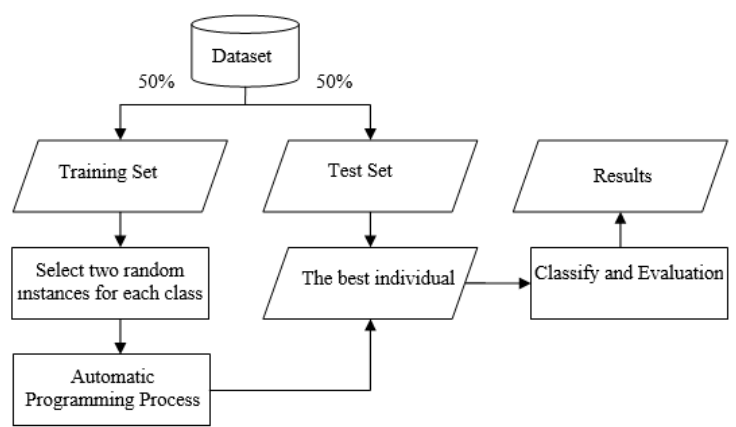
Figure 4. General mechanism of descriptor.